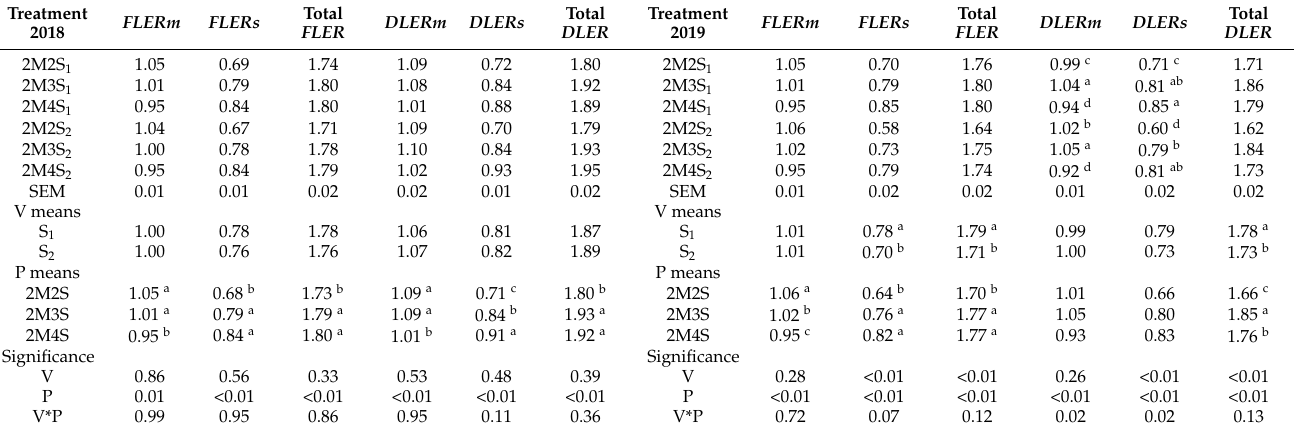
Table 3. Land equivalent ratios of maize and soybean as affected by different planting patterns in